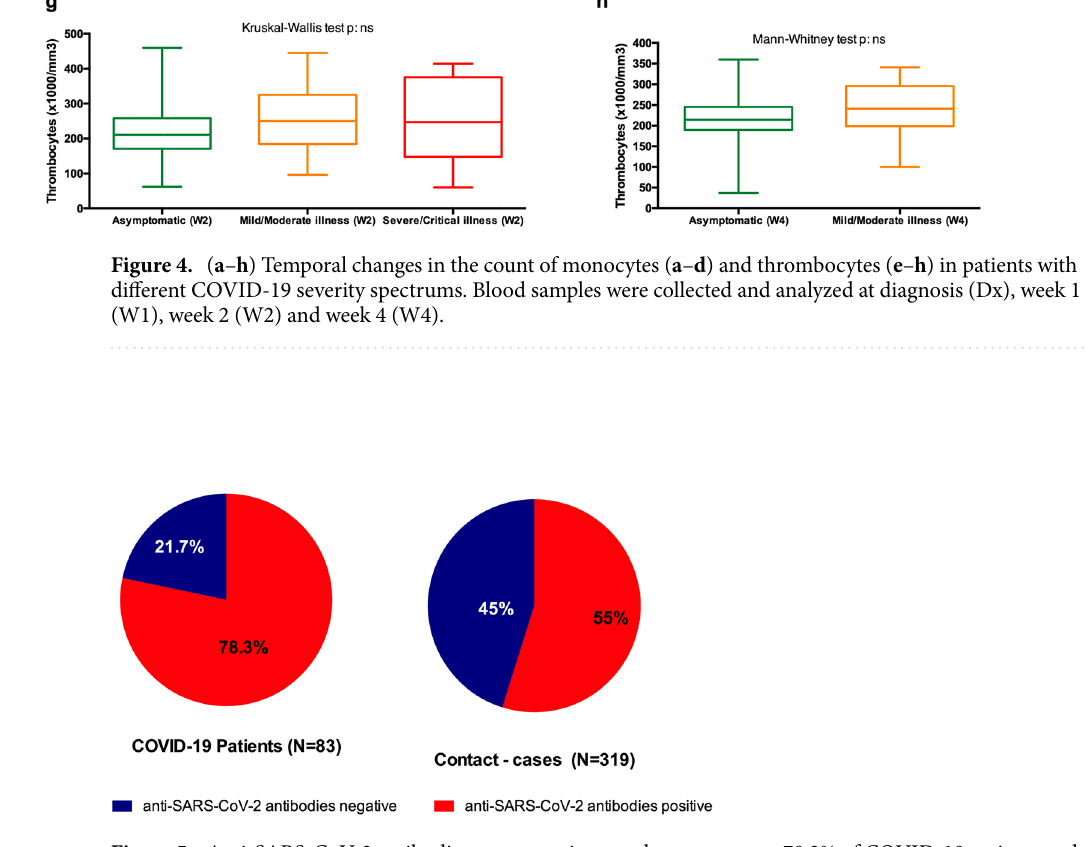
Figure 5. Anti-SARS-CoV-2 antibodies among patients and contact-cases. 78.3% of COVID-19 patients and 55% of SARS-CoV-2 PCR negative contact-cases had anti-SARS-CoV-2